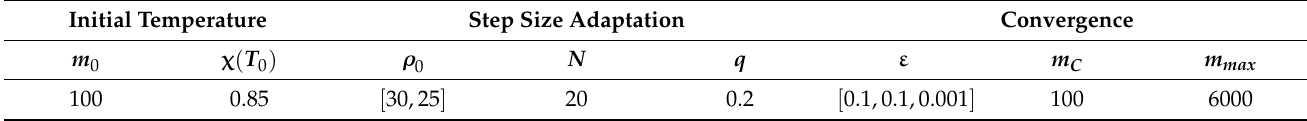
Table 8. Parameters of the simulated annealing algorithm for the shape optimization.